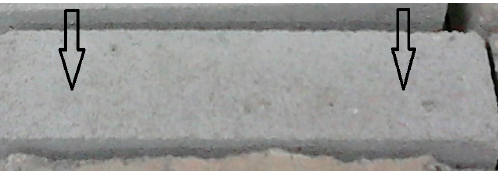
Figure 9. Compressive strength test of a laboratory beam with dimensions of 4 × 4 × 16 cm.